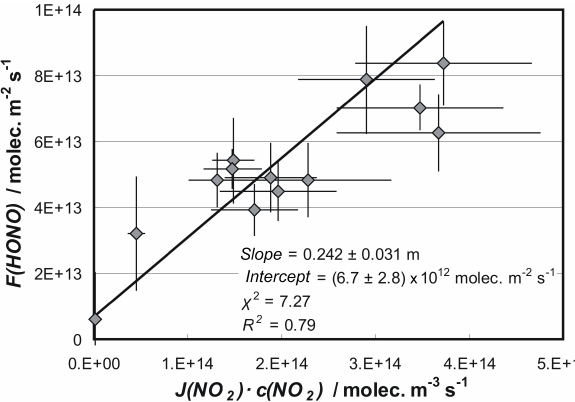
Figure 5. Correlation of the diurnal HONO flux (06:00 to 20:00UTC) with the product J (NO 2 ) · c (NO 2 ) during PHOTONA 1 with a weighted orthogonal regression fit (Brauers and Finlayson- Pitts,